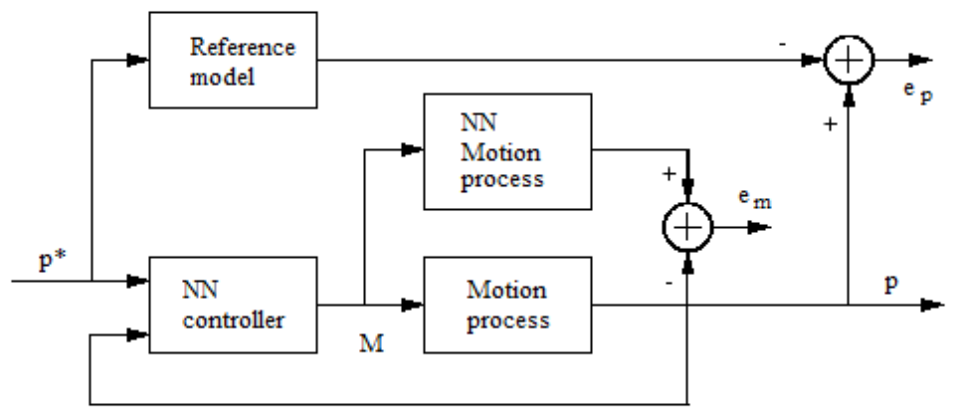
Figure 16. Neural model reference control structure.